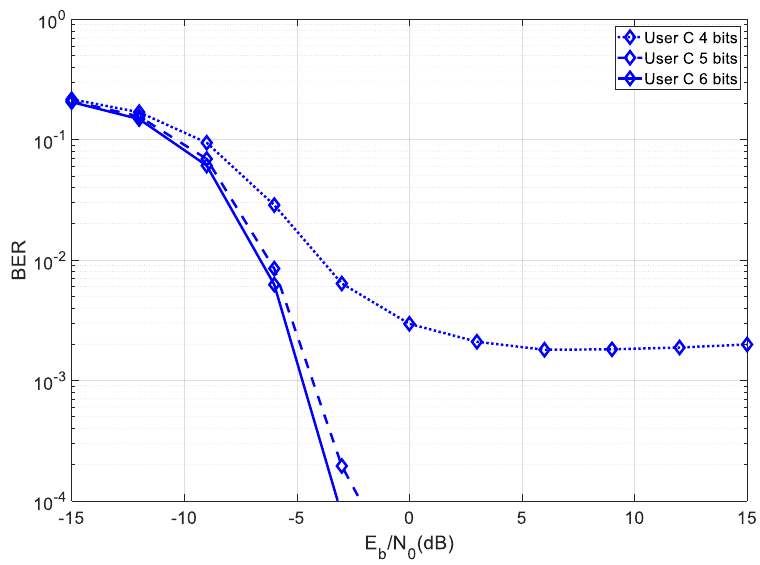
Figure 4. BER of a 2 × 2 system at User C, considering four IB-DFE iterations and different resolutions for quantization of the partial key Q k .